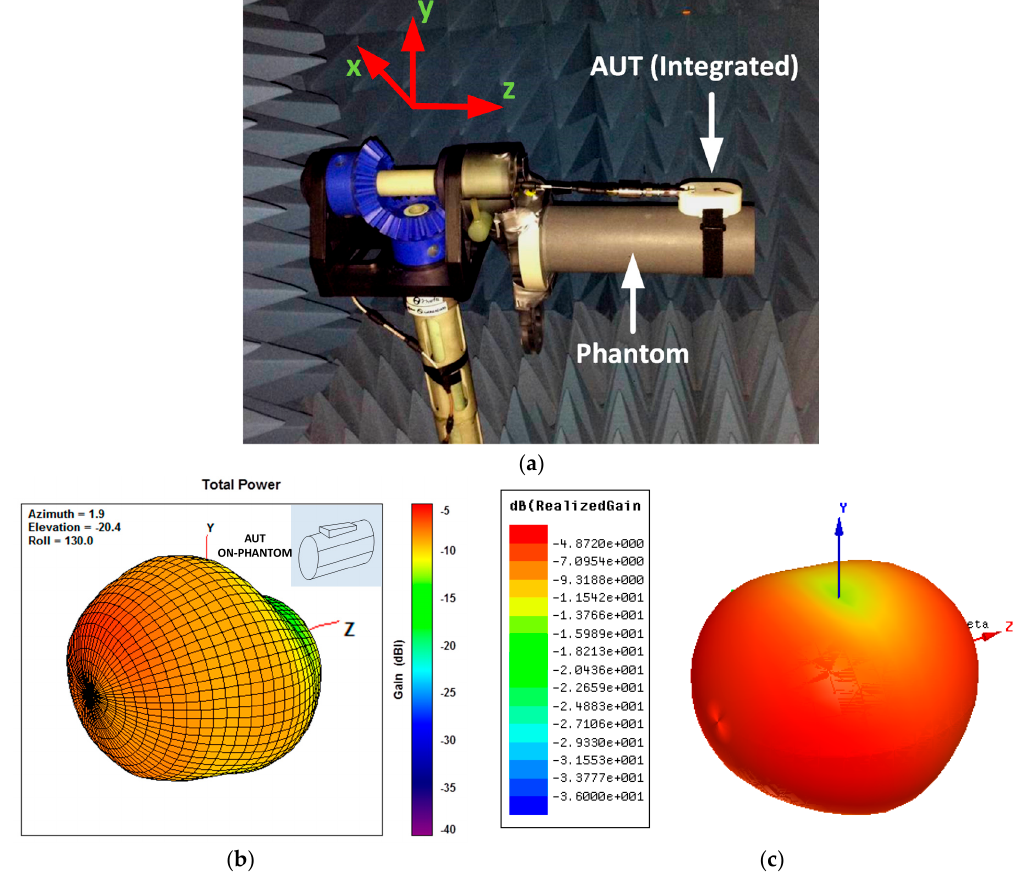
Figure 13. ( a ) antenna measurement setup on IXB-063 phantom column scenario; ( b ) measured 3D radiation pattern of the antenna system placed on IXB-063 phantom column; ( c ) simulated 3D radiation pattern of the antenna system placed on IXB-063 phantom column. Table 8. Comparison between measured and simulated radiation characteristics of the antenna on the IXB-063 phantom column.